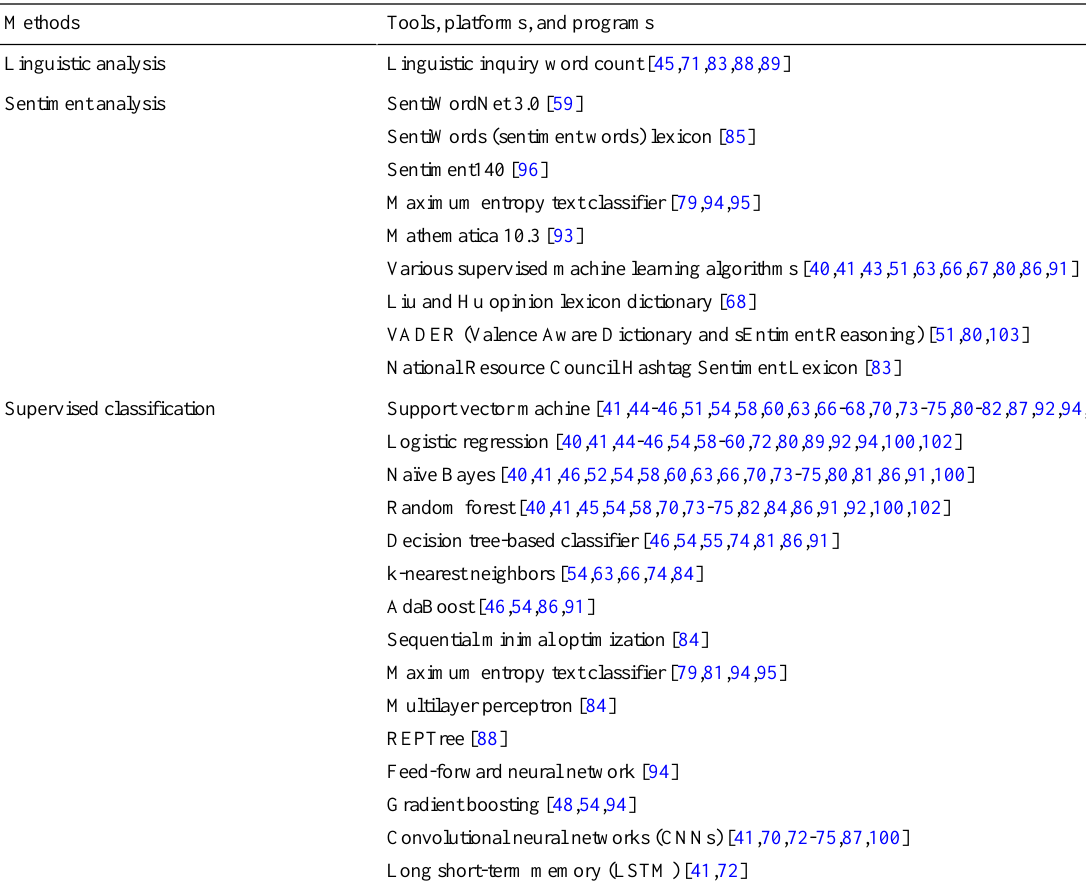
Table 3 [40-46,48-55,57-89,91-103] highlights the summary of methodological functions used across various studies and also lists the specific tools used for performing those functions.